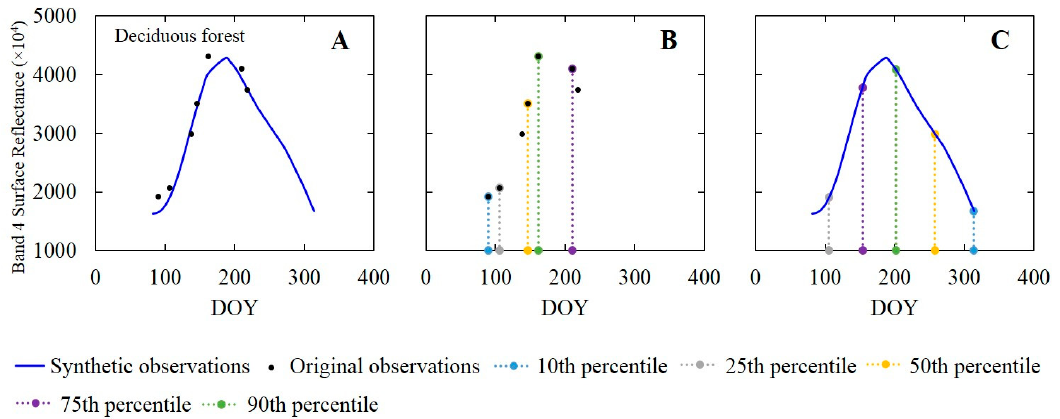
Figure 4. Illustration of the generation of time-series model (TSM)-adjusted percentile features for deciduous forest: ( A ) time-series model based on clear Landsat band 4 observations over a given year, ( B ) the original percentile features generated using time-series of clear observations, and ( C ) the TSM-adjusted percentile features generated using synthetic time-series observations.